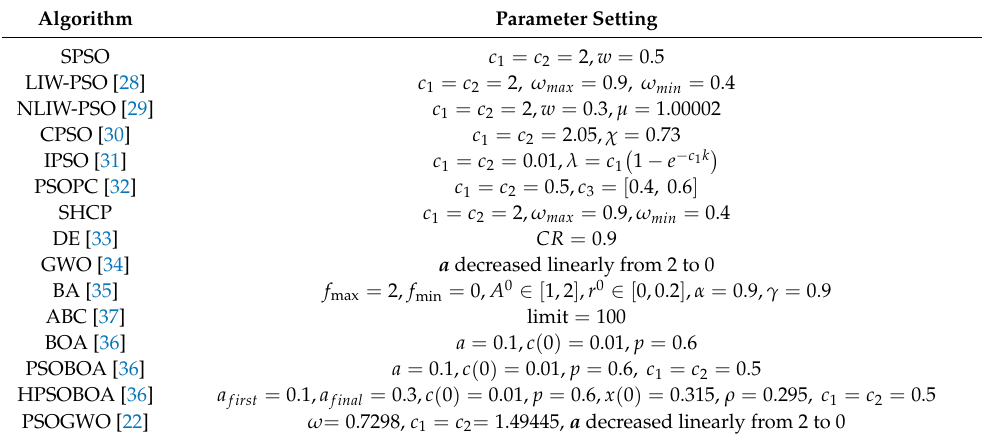
Table 2. Parameter settings of compared algorithms.